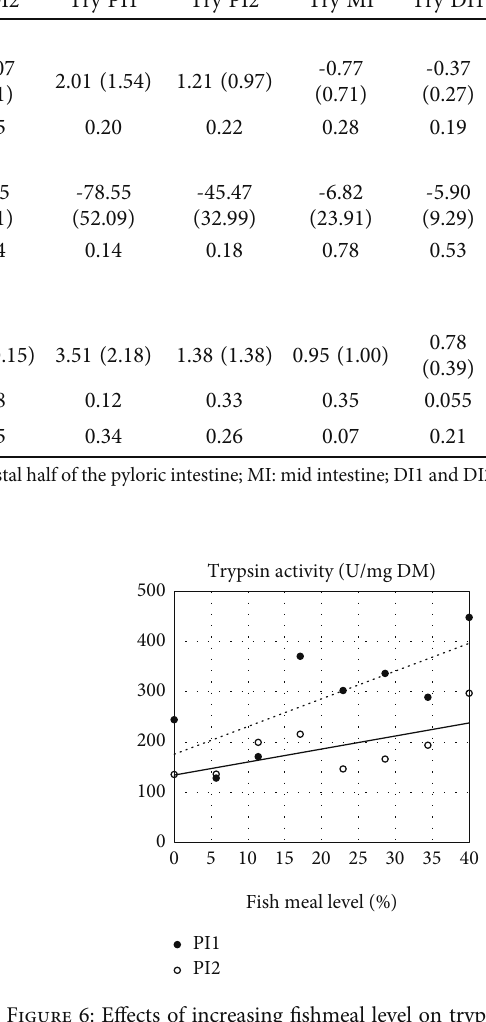
Figure 5: E ff ects of increasing fi shmeal level on bile salt concentration in chyme from the distal half of the pyloric intestine (PI2) in fi sh fed two series of diets, one without (No suppl) and the other with (Suppl) mixture of supplements, i.e., 0.3% choline chloride, 0.05% β -glucan, and 0.05% nucleotides. For statistics, see Table 5.